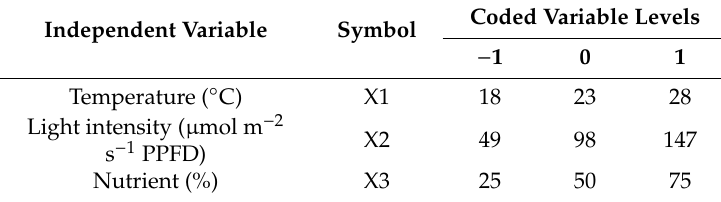
Table 5. Independent variables and their levels in coded and actual